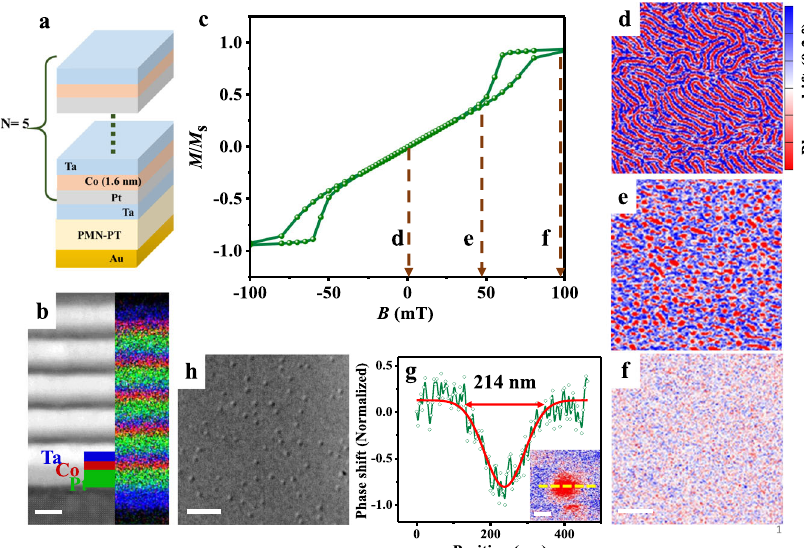
Fig. 1 Structure and skyrmion characterizations. a Schematic of the sample con fi guration. b Cross-sectional HAADF-STEM image of the multilayer and corresponding EDX mapping for element distributions of Pt (green), Co (red) and Ta (blue) with a scale bar of 5 nm. c Out-of-plane magnetic hysteresis. d – f Magnetic-domain evolutions with increasing magnetic fi eld with the same scale bar of 1 μ m. g Line-cut pro fi le along the yellow dot line in the inset with Gaussian fi tting (red curve), the inset is magni fi ed individual skyrmion with a scale bar of 100 nm. h Representative L-TEM image of skyrmions with a scale bar of 1 μ